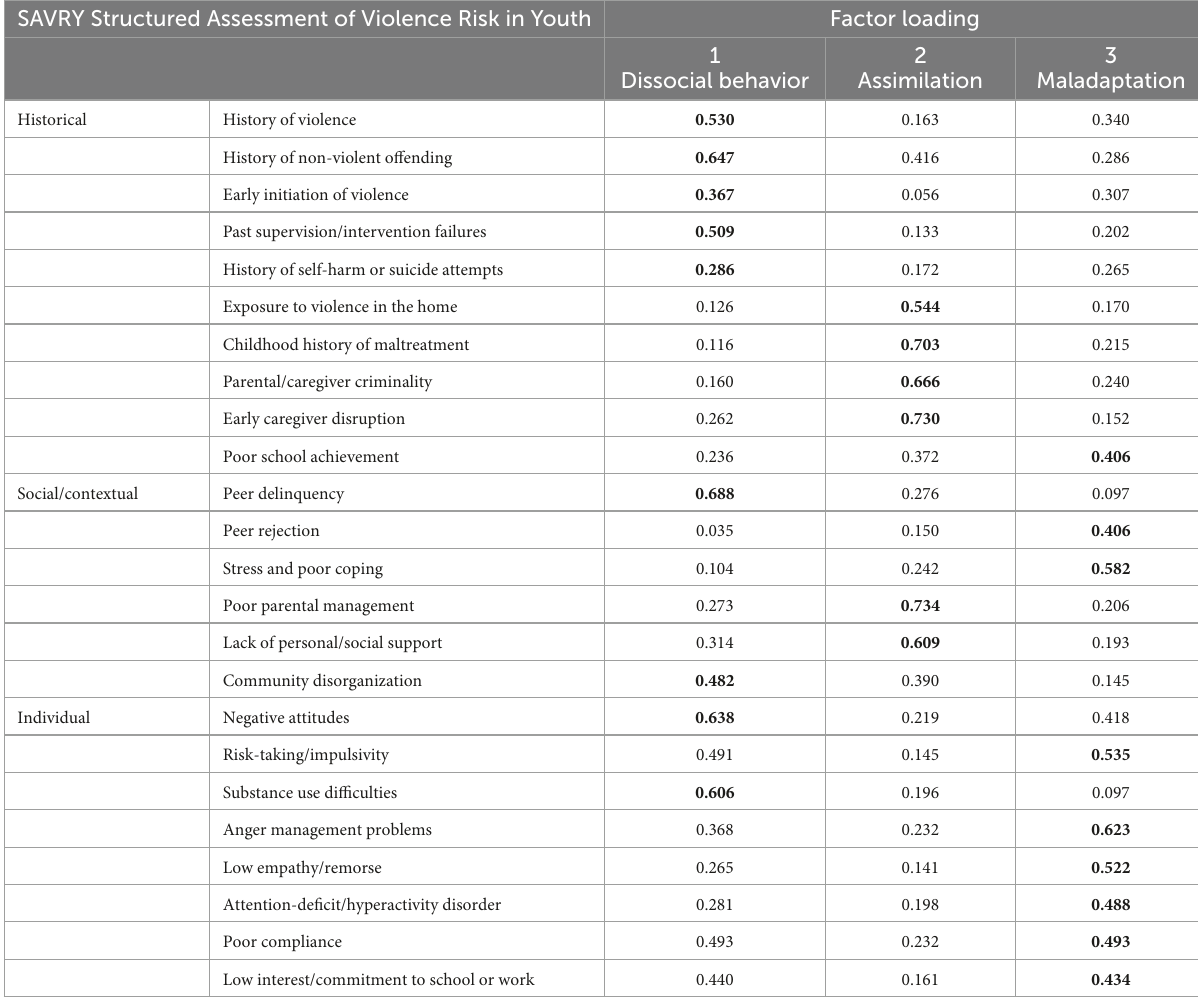
TABLE 1 Structured Assessment of Violence Risk in Youth (SAVRY) factor analysis. SAVRY Structured Assessment of Violence Risk in